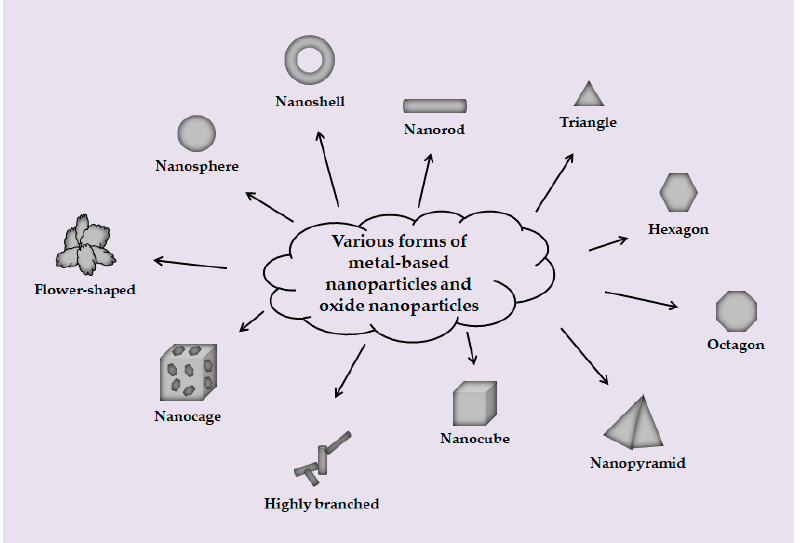
Figure 2. A summary of the various forms of metal-based NPs and oxide NPs. Metal-based NPs and oxide NPs have very rich forms. In addition to surface chemistry and optical properties, the morphology of ENPs also has an impact on their function. Therefore, people usually adjust the corresponding reaction conditions in the process of nanomaterials synthesis to produce various forms of ENPs, such as nanosphere, nanoshell, nanorod, triangle, hexagon, octagon, nanopyramid, nanocube, highly branched, nanocage, flower-shaped, etc., so as to meet their actual